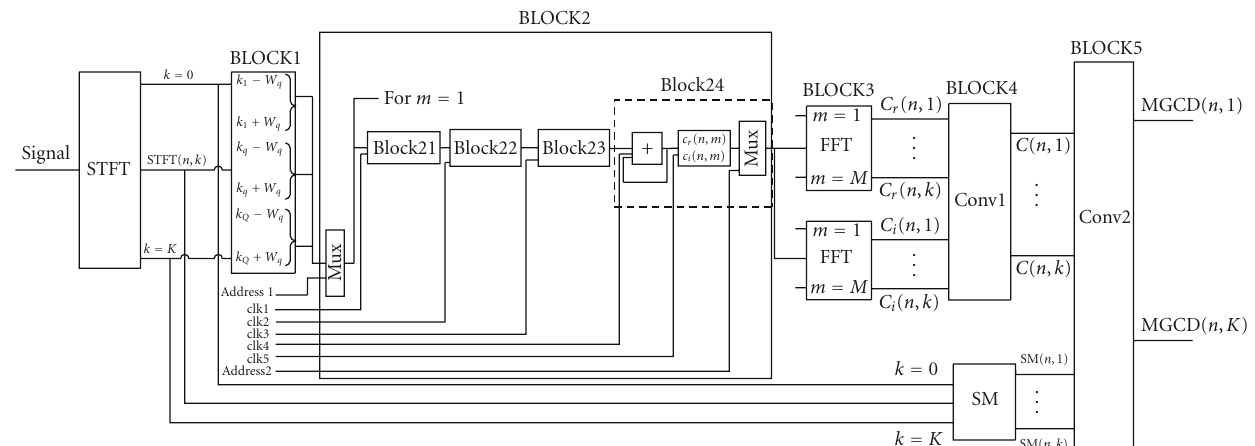
Figure 10: Serial architecture for realization of generalized complex-lag distribution for multicomponent